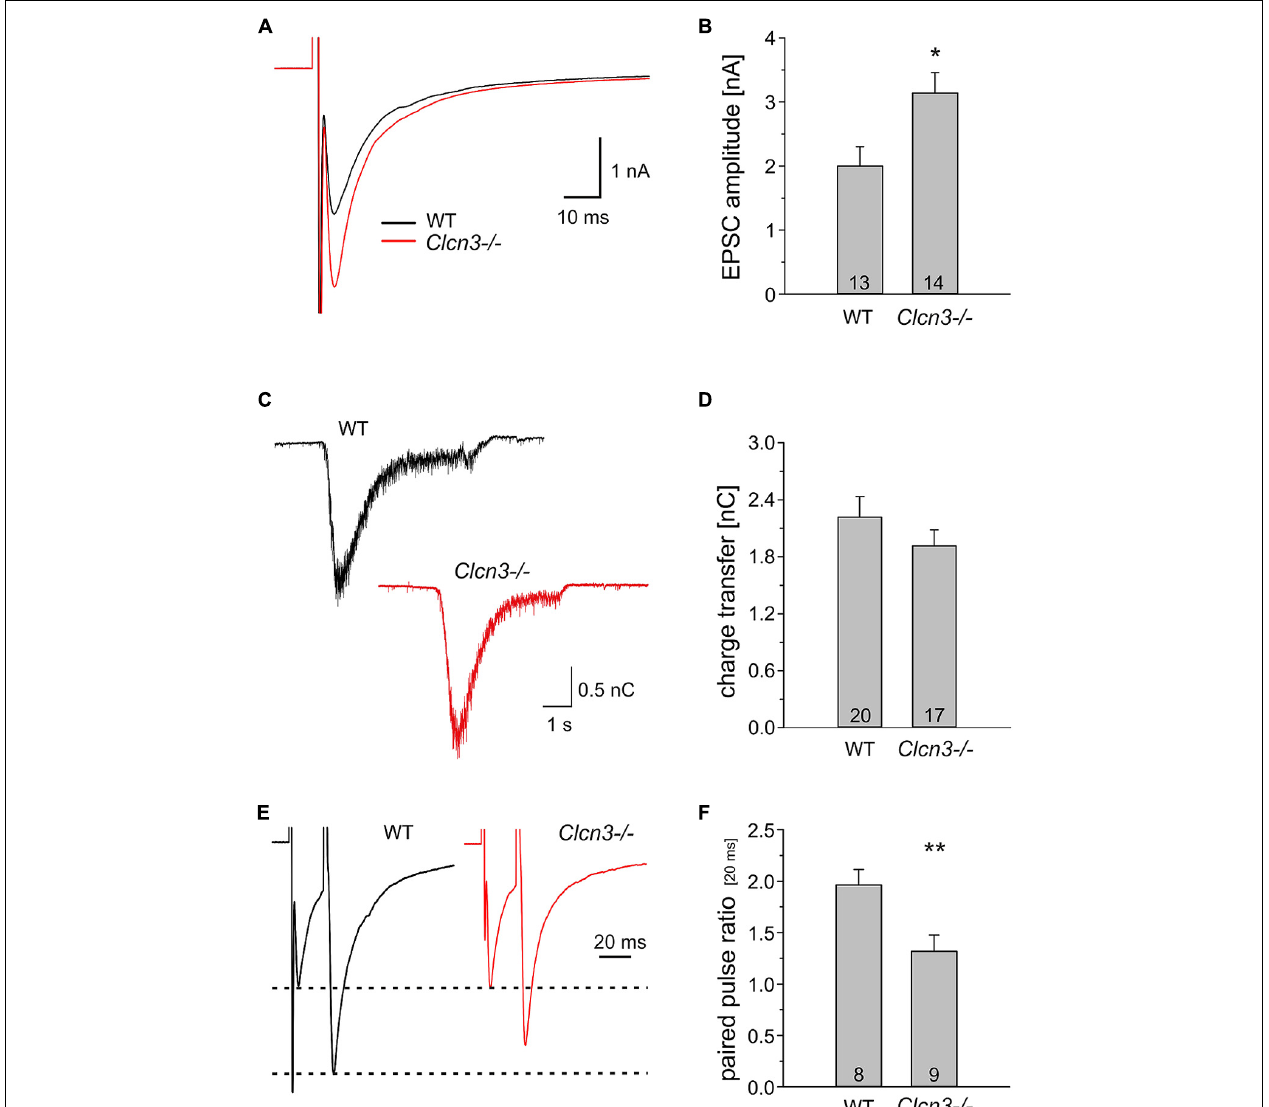
FIGURE 3 | Evoked synaptic signals are larger in Clcn3 − / − than inWT neurons. (A) Averaged evoked EPSCs from hippocampal neurons fromWT (black trace) or Clcn3 − / − neurons (red trace). (B) Mean EPSC amplitudes fromWT and Clcn3 − / − neurons. (C) Representative secretory responses to stimulation with 500 mOsm sucrose fromWT (black trace) or Clcn3 − / − neurons (red trace). (D) Mean ± SEM for readily releasable pool (RRP)